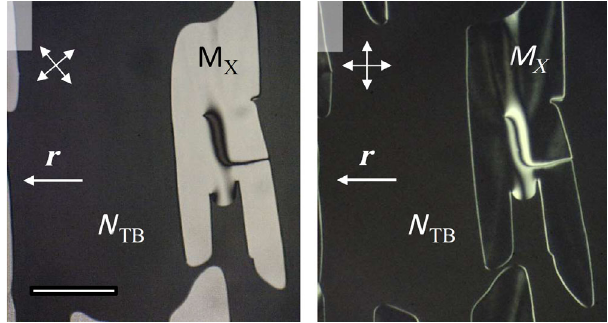
FIG. 5. Growth of a homeotropic M domain within the N X TB ¼ 25 V, d ¼ 1 . 4 μ m, T ¼ 100 °C). under an electric field ( U rms The observation of birefringence while rotating the crossed polarizers (white double-headed arrows) reveals that the domain is biaxial, with m parallel to r . (Scale bar 100 μ